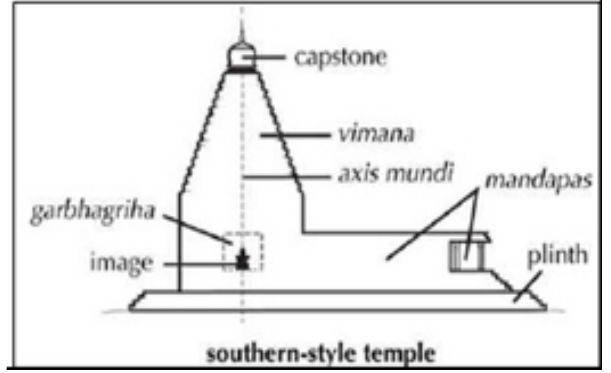
Figure 1 Elements of Dravidian Style Temple (Vardia, 2008)